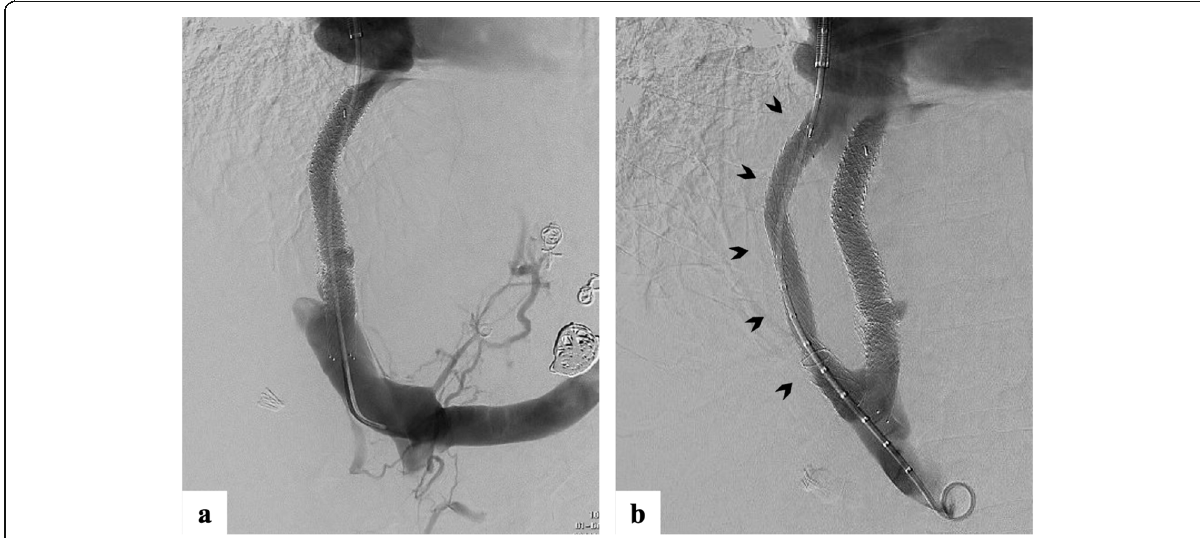
Fig. 3 Venogram during the parallel TIPS procedure demonstrating ( a ) a patent primary shunt; ( b ) the newly created parallel TIPS (arrowheads) extending from the right hepatic vein to the right portal vein alongside the primary